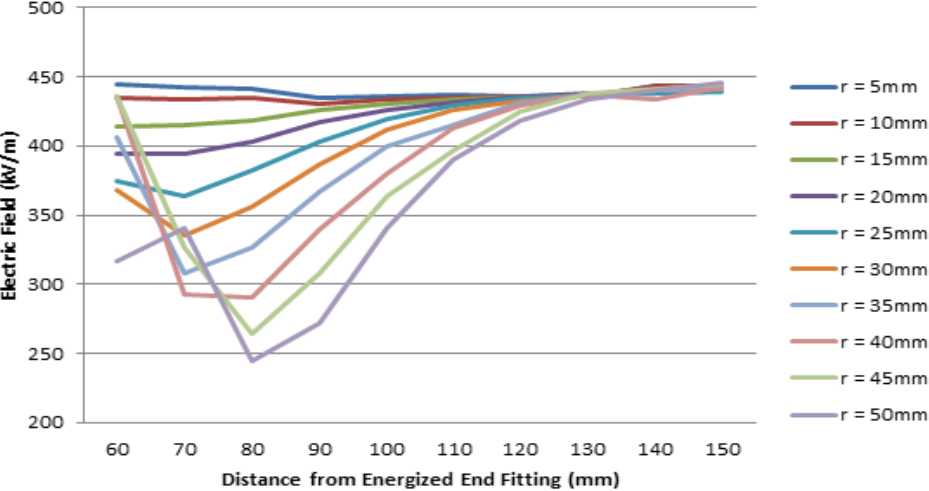
Figure 10. Electric field at point 116 for the variation in r and R.